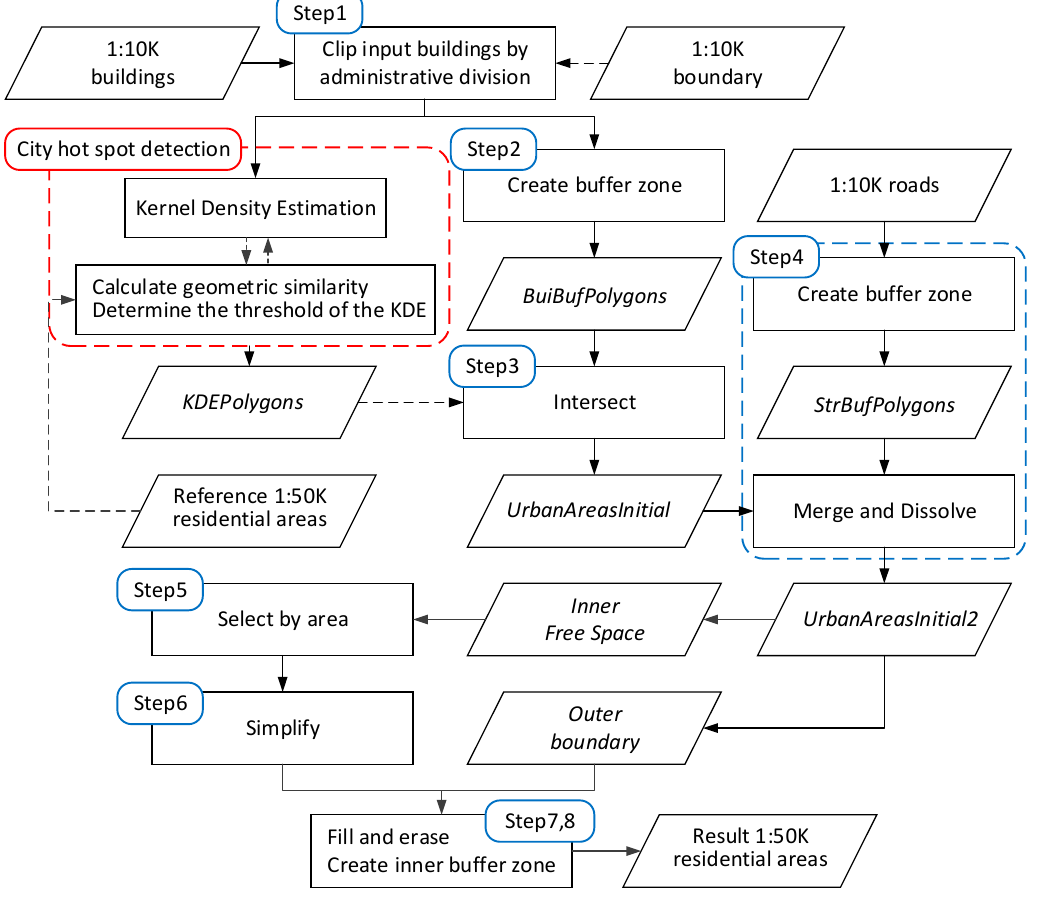
Figure 7. Procedures of the proposed method.